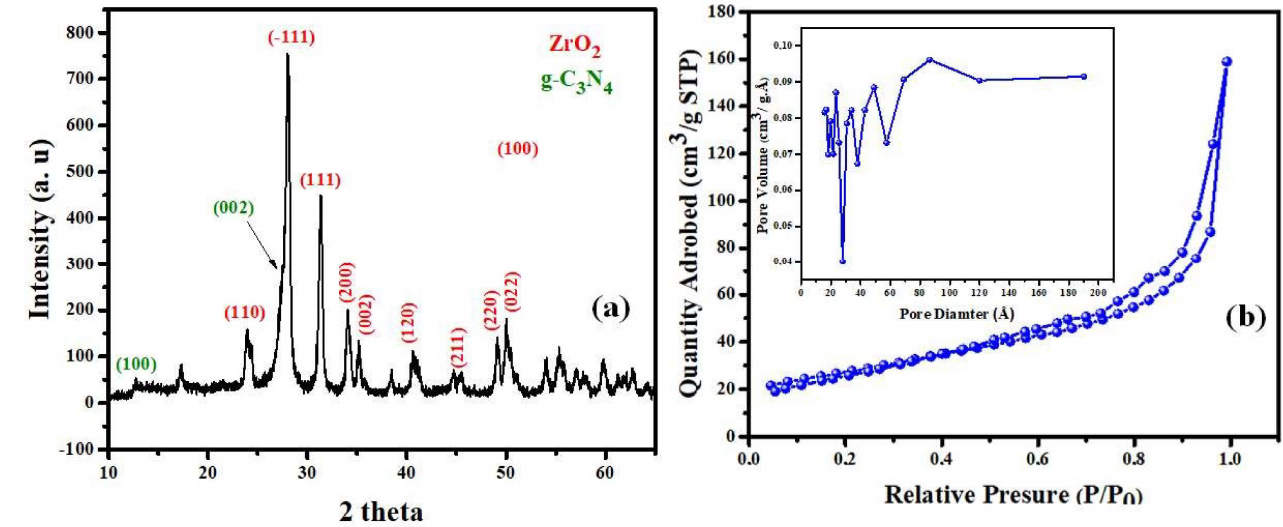
Figure 1. ( a ) XRD pattern; ( b ) N 2 sorption–desorption isotherm of Zr-G-C 3 N 4 sorbent. The inset in ( b ) presents the pore size distribution. Figure 2 illustrated SEM morphological observations with EDX chemical analysis and elemental mapping of the nanocomposite before the adsorption process.